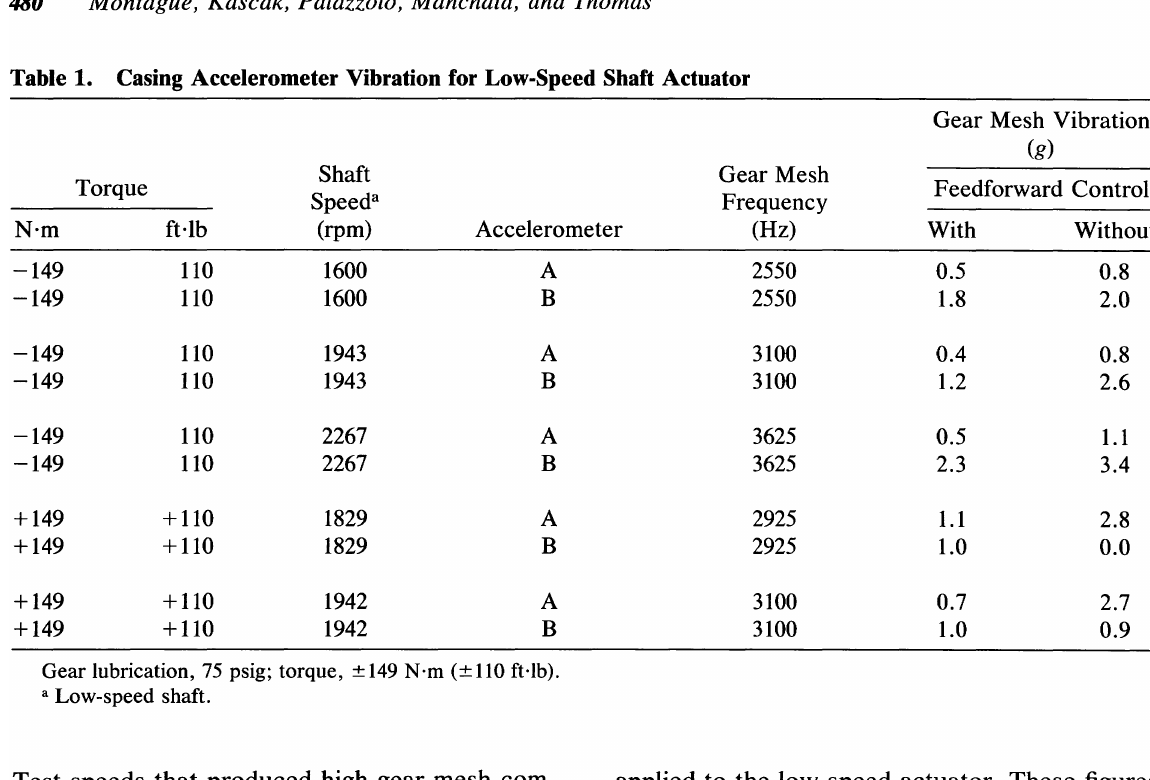
Table 1. Casing Accelerometer Vibration for Low-Speed Shaft Actuator Torque